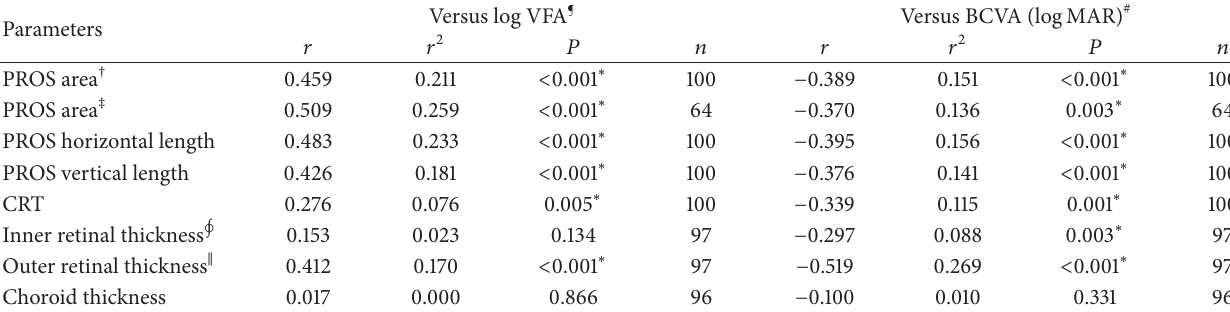
Table 2: Univariable